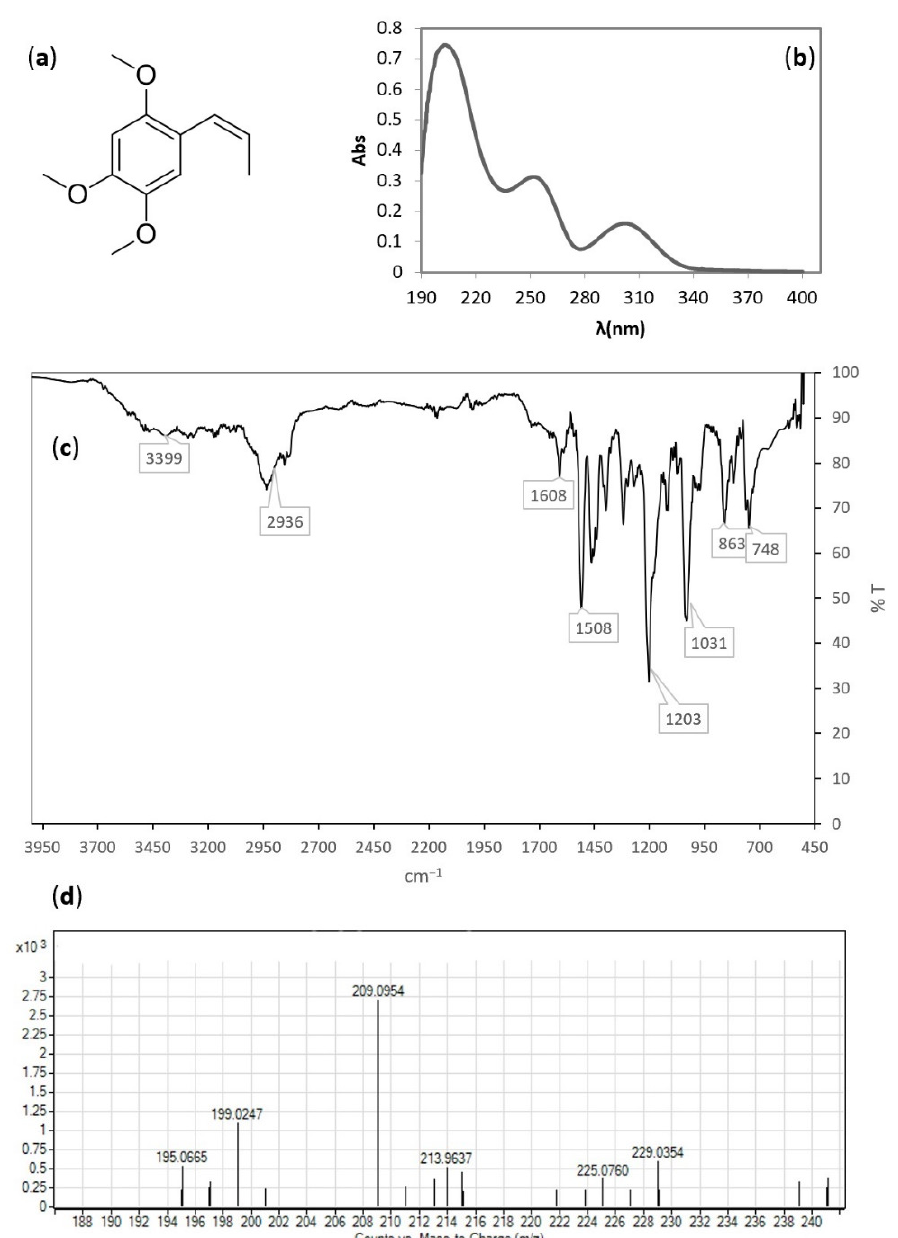
Figure 3. ( a ) The chemical structure, ( b ) UV, ( c ) IR and ( d ) HRMS spectra of